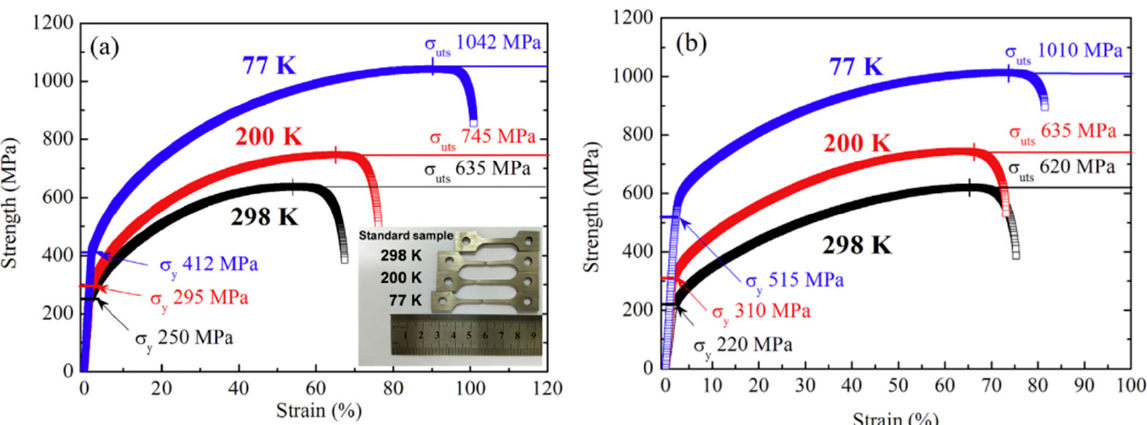
Figure 6. Representative engineering stress–strain curves of the ( a ) Al 0.1 and ( b ) Al 0.3 alloys at the three testing temperatures. Reprinted with permission from Ref. [28]. Copyright 2016, Elsevier.